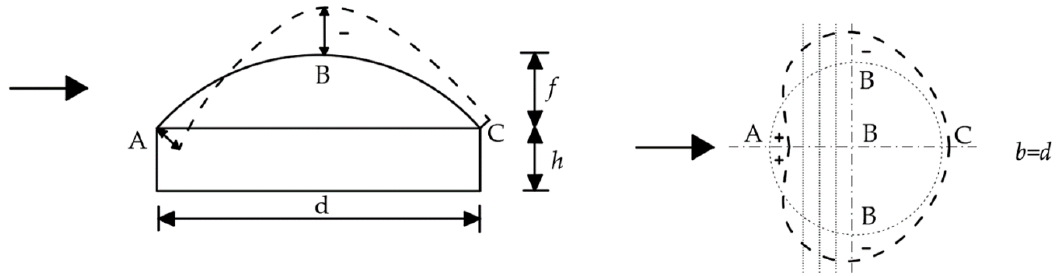
Figure 11. The values of angles α n and δ n.